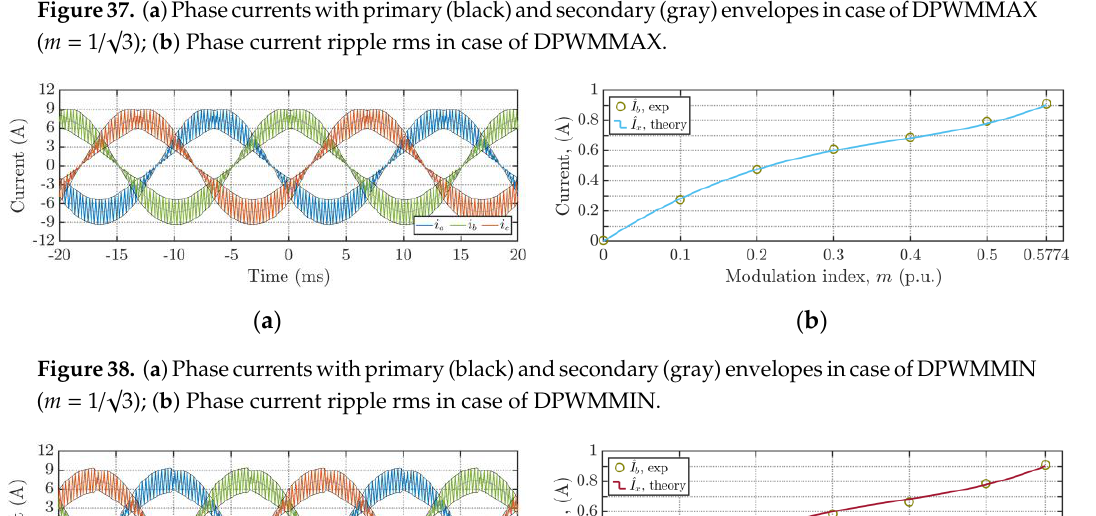
DPWMMAX ( m = 1/√3); ( b ) Phase current ripple rms in case of DPWMMAX. Figure 37. ( a ) Phase currents with primary (black) and secondary (gray) envelopes in case of